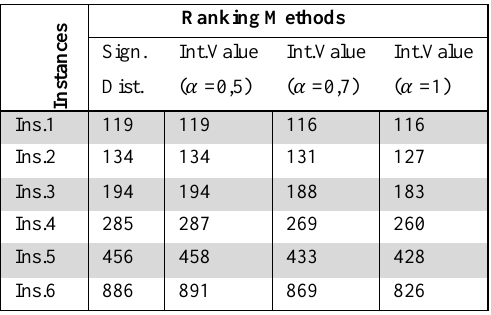
integral value with various α values.